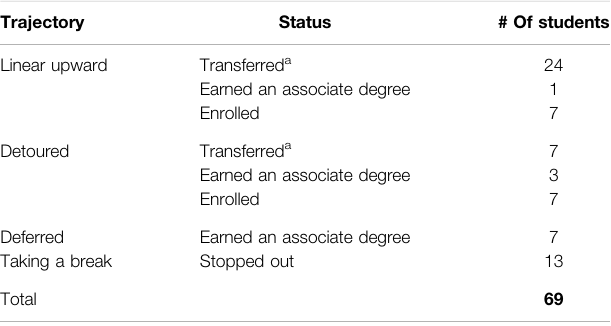
TABLE 7 | Transfer and associate degree completion status of Inspire Scholars Program participants by momentum trajectory.